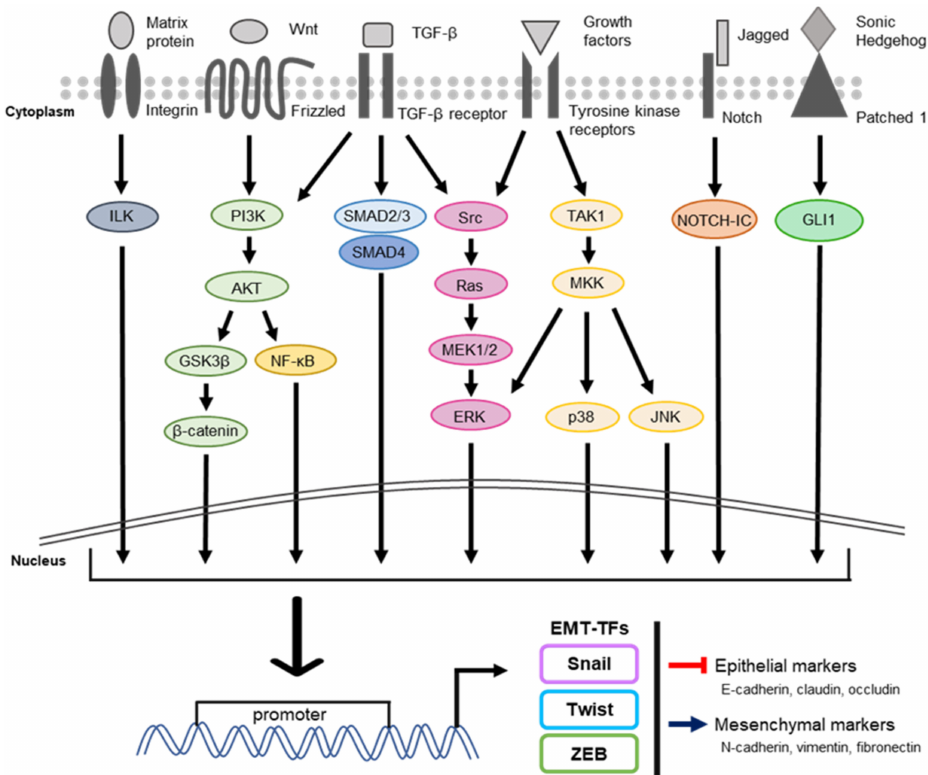
Figure 2. The common signaling pathways regulating EMT. The progression of EMT is controlled by several extracellular and intracellular signaling pathways. Their coordinated interactions bind to DNA promoter regions of EMT-TFs, leading to promotion of transcriptional activity of EMT-TFs. The expressions of EMT-TFs play a key role in regulating the expression of their target genes related to EMT and cancer metastasis. (Left to right: matrix protein/ILK, WNT/PI3K/ β - catenin, TGF- β /PI3K/NF- κ B, TGF- β /SMAD complex, growth factors or TGF- β /RAS/ERK, growth factors/TAK1/MAPK, Jagged/NOTCH-ICD, and Sonic Hedgehog/GLI1) ILK, integrin-linked kinase; TGF- β , transforming growth factor-beta; PI3K, phosphoinositide 3-kinase; NF- κ B, nuclear factor-kappa B; ERK, extracellular signal-regulated kinase; JNK, c-Jun N-terminal kinases; MAPK, mitogen-activated protein kinase; TAK1, transforming growth factor β -activated kinase 1; MEK, MAPK/ERK kinase; MKK, mitogen-activated protein kinase